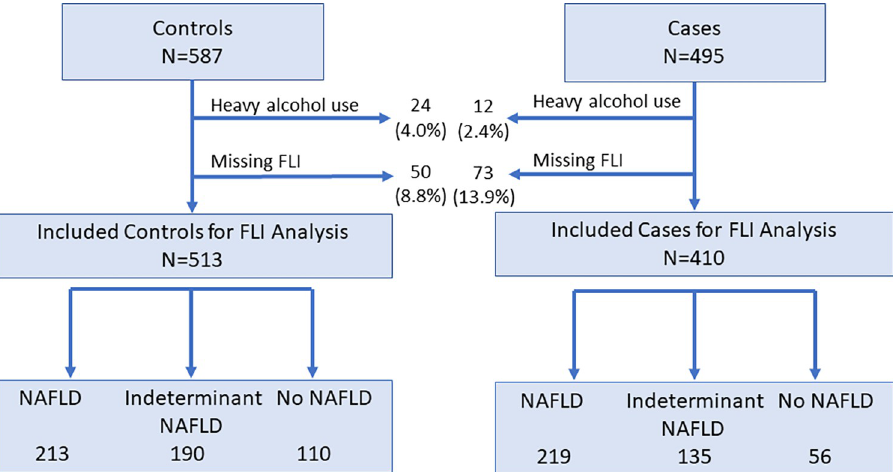
Fig 1. Inclusion of cases and controls in the analysis of the association of FLI with risk of incident cognitive impairment.